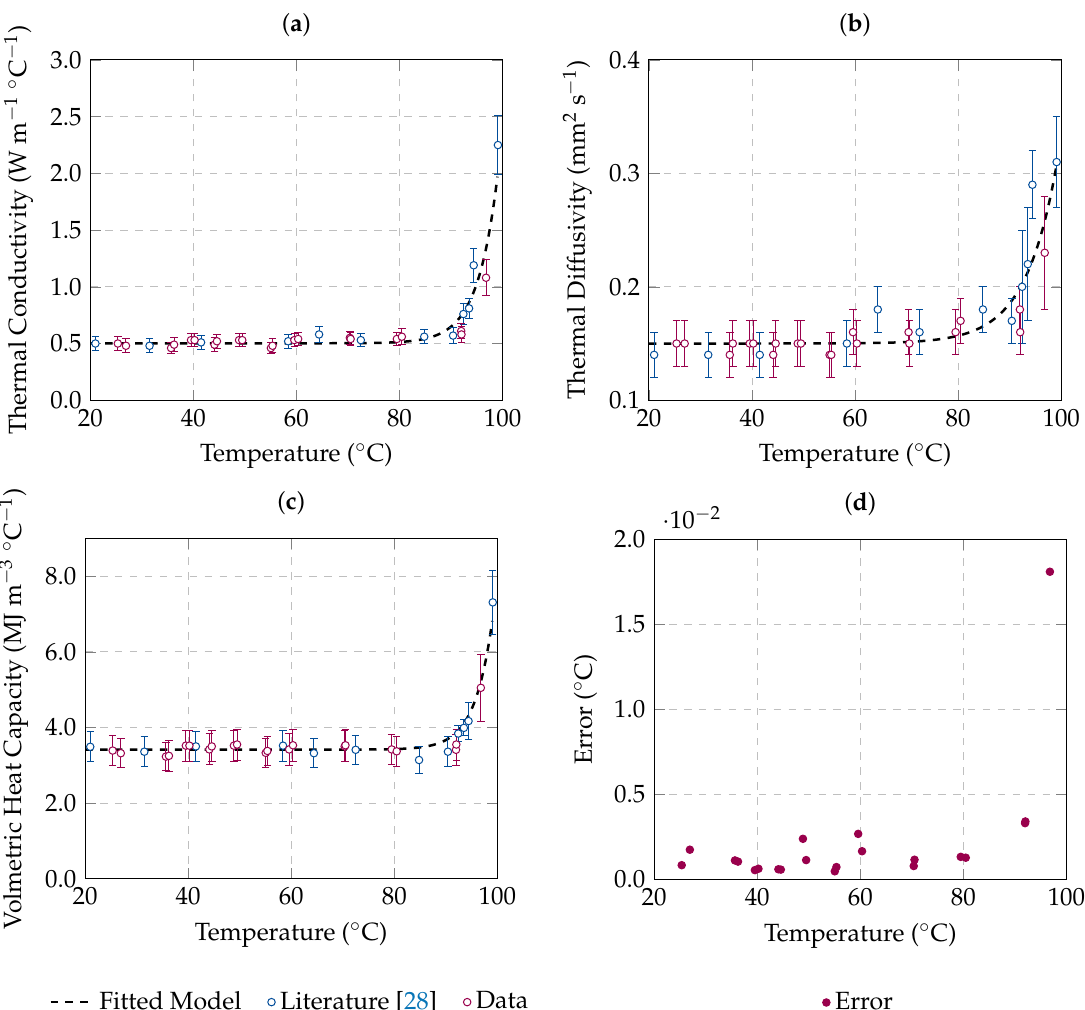
Figure 3. Thermal properties of ex vivo ovine liver as a function of the increasing temperature: ( a ) thermal conductivity, ( b ) thermal diffusivity and ( c ) volumetric heat capacity. Average values are reported with the associated uncertainty (error bars). Experimental data (red) as well as literature data (blue) are shown. The best fit model is also presented by a dashed line. The estimated error of how well the least square model fits the data is reported in ( d